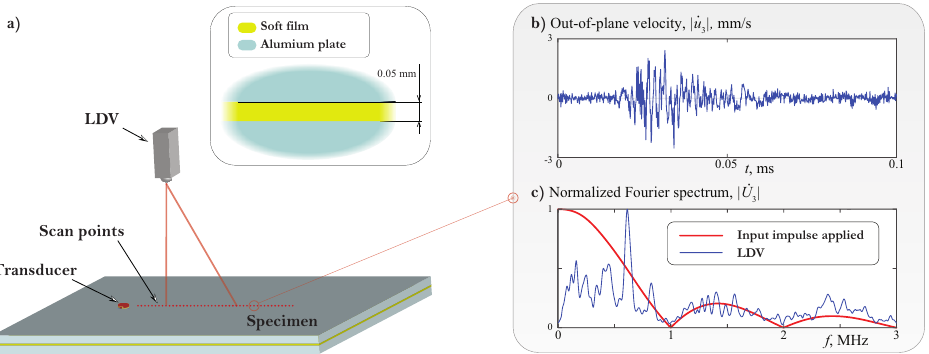
Figure 17. Sketch of the experimental setup ( a ). Out-of-plane velocities ( b ) and their spectrum ( c ) measured by the LDV at a point located 70 mm away from the piezoelectric actuator center after its broadband excitation with 1 µ s rectangular pulse tone burst